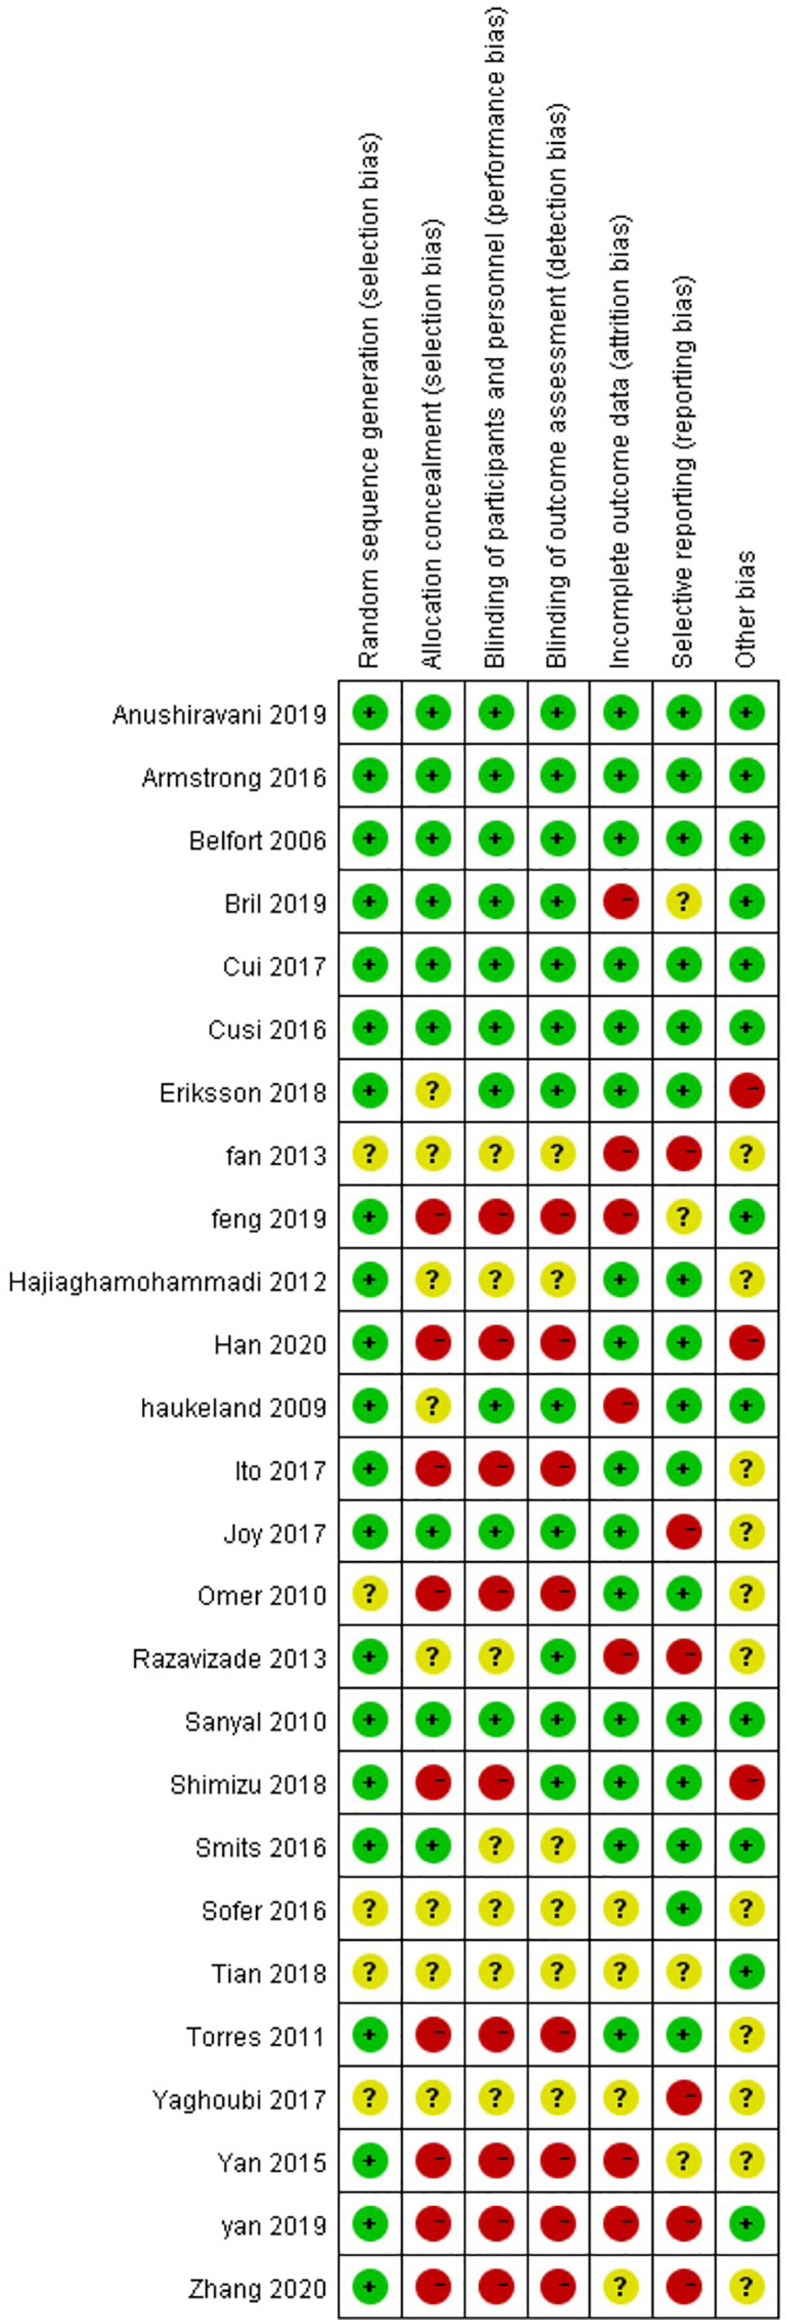
Risk of bias summary for the review authors’ judgments about each risk-of-bias item for each included study.